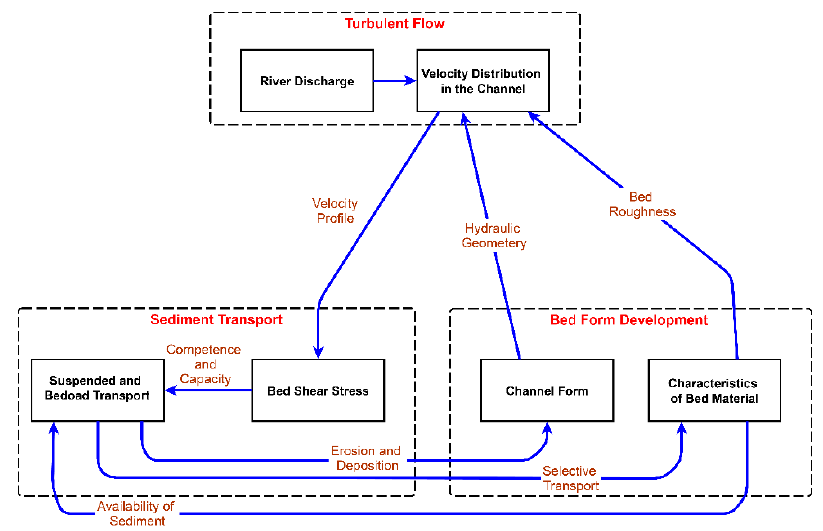
Figure 4. Unification of conceptual models by Leeder [11] and Ashworth and Ferguson [12].